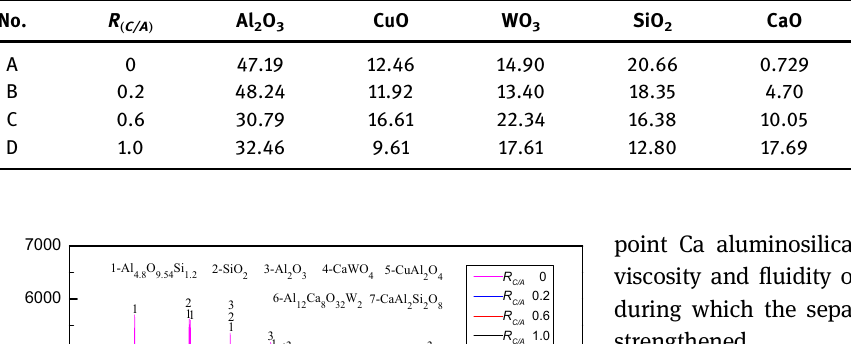
Table 2: Composition of the slags obtained with di ff erent R ( C/A ) , wt% No.